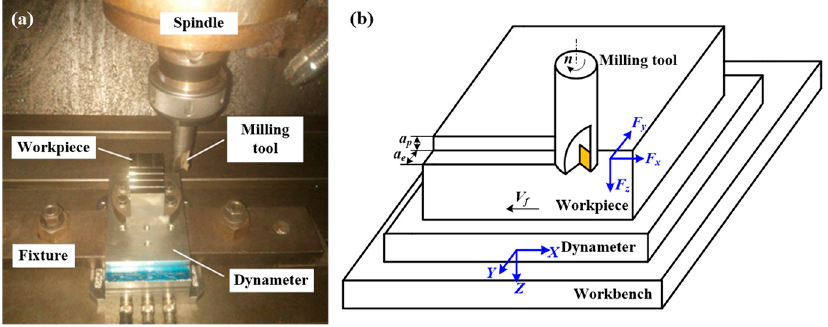
Figure 2. ( a ) Experimental setup and ( b ) illustration of cutting parameters in asymmetry milling.